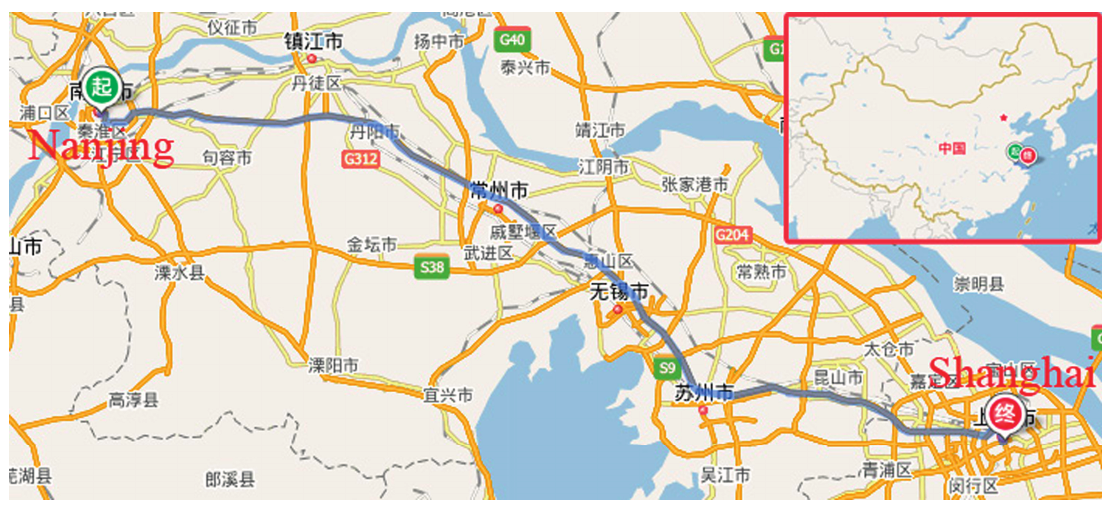
Figure 3. Experiment